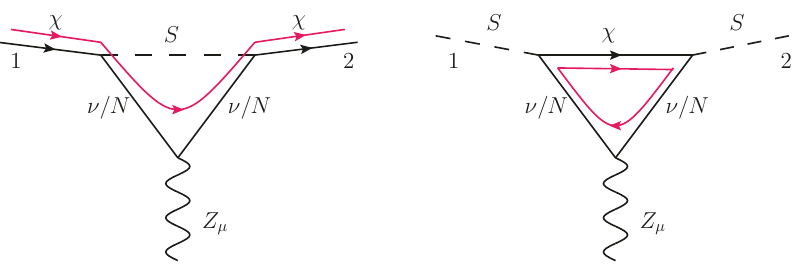
Figure 9 . The loop induced vertices Z both Dirac and Majorana fermions, we use the convention in [88] to calculate the amplitude. The red arrows represent the fermion (cid:13)ow along which the amplitude for the fermion line is calculated. where g is the SU(2) L coupling, c W Weinberg angle, C 0 and C 00 are the loop functions in the convention of LoopTools [89] and 0 (cid:0) corresponds to the momentum transfer square in the scattering which is negative and close to